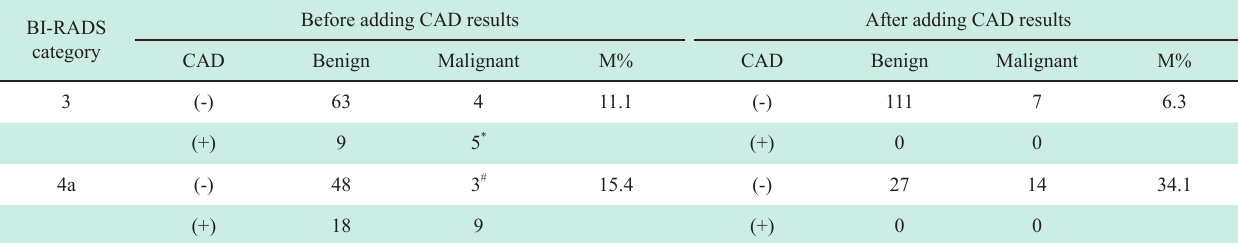
Table 5 Distribution of category 3 and 4a lesions analyzed by inexperienced radiologists and CAD results: before and after adding CAD results according to Method 3 ( n = 159) BI-RADS